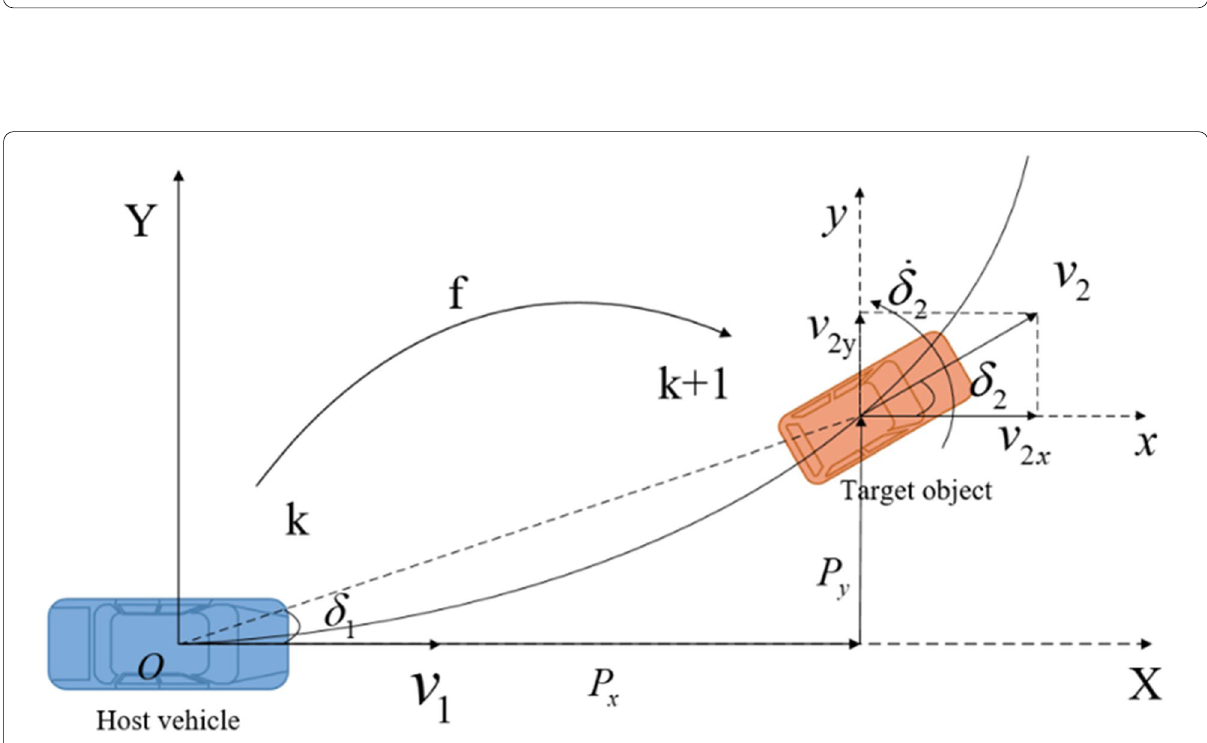
Figure 3 Detection range of radar and LiDAR (the yellow rectangle target is the target detected by LiDAR, and the blue circle target is the target detected by radar)